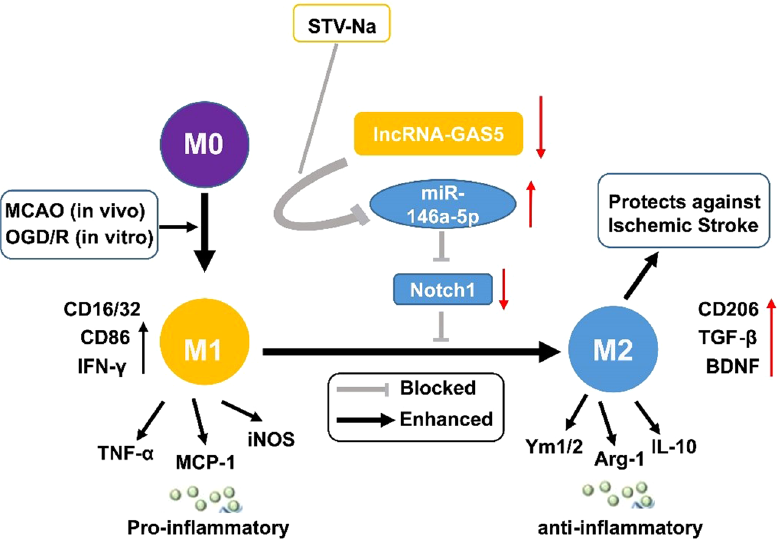
Figure 11. Schematic diagram of STV-Na effect on brain damage post stroke. STV-Na exerts neuroprotection by phenotypic modulation of the microglia/macrophage shift. STV-Na disrupted the GAS5/miR-146a-5p to inhibit Notch1 expression after stroke in vivo and in vitro . Thus, expression of pro-inflammatory cytokines was suppressed and the polarization of microglia/macrophages was shifted to the M2